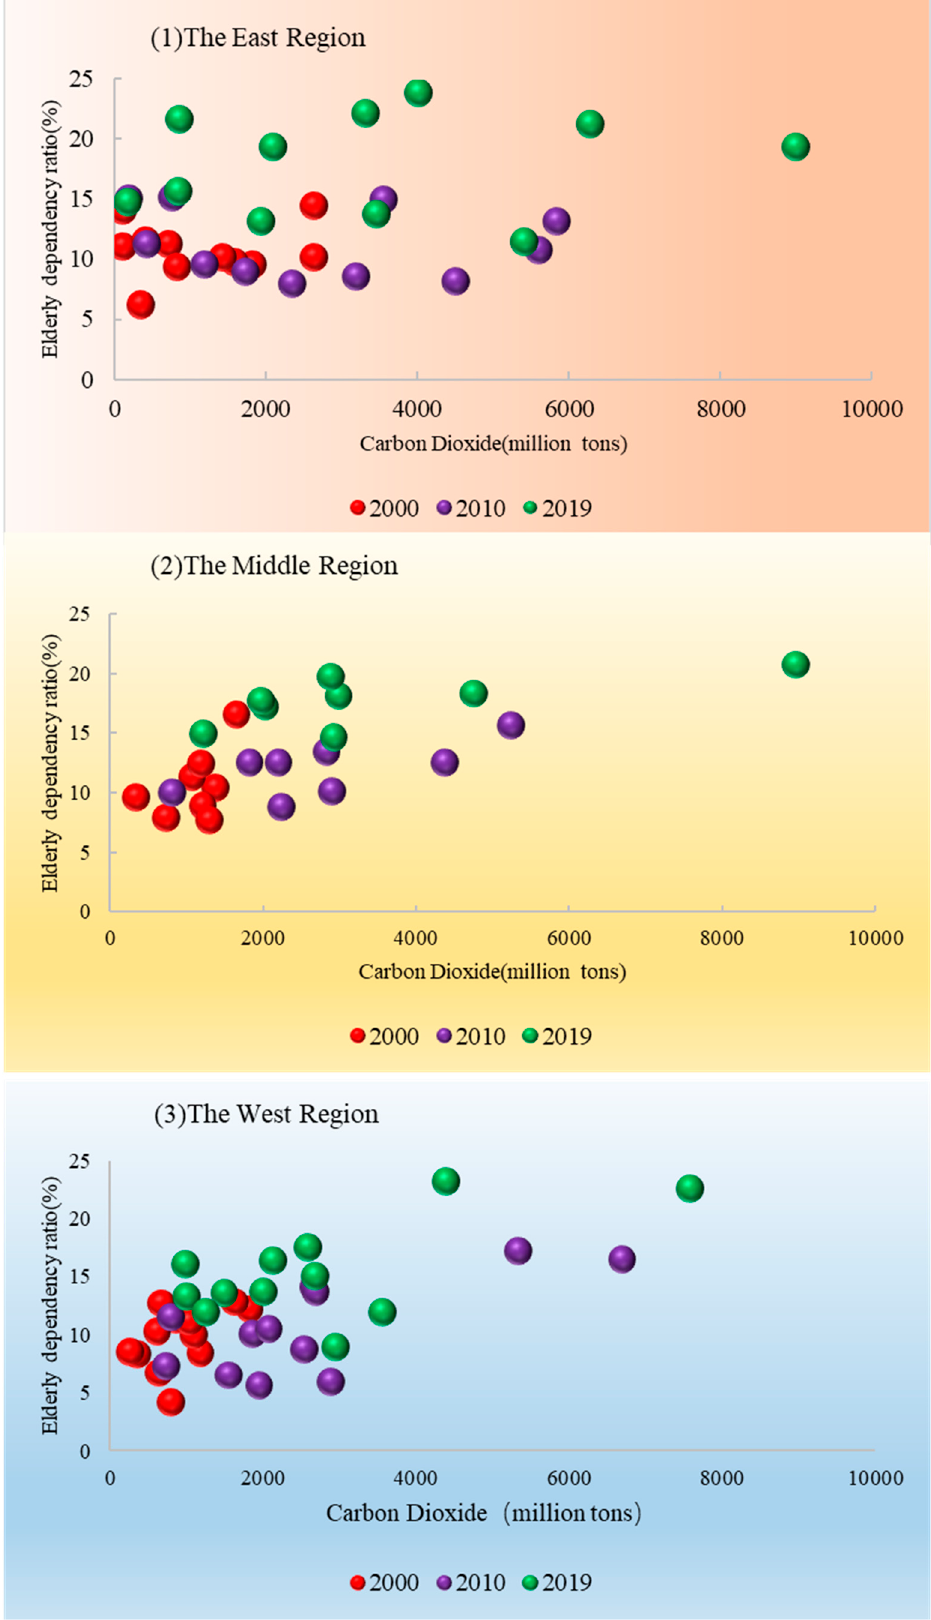
Figure 2. Ageing dependency ratio and carbon emissions in East Midwest Region, 2000/2010/2019.